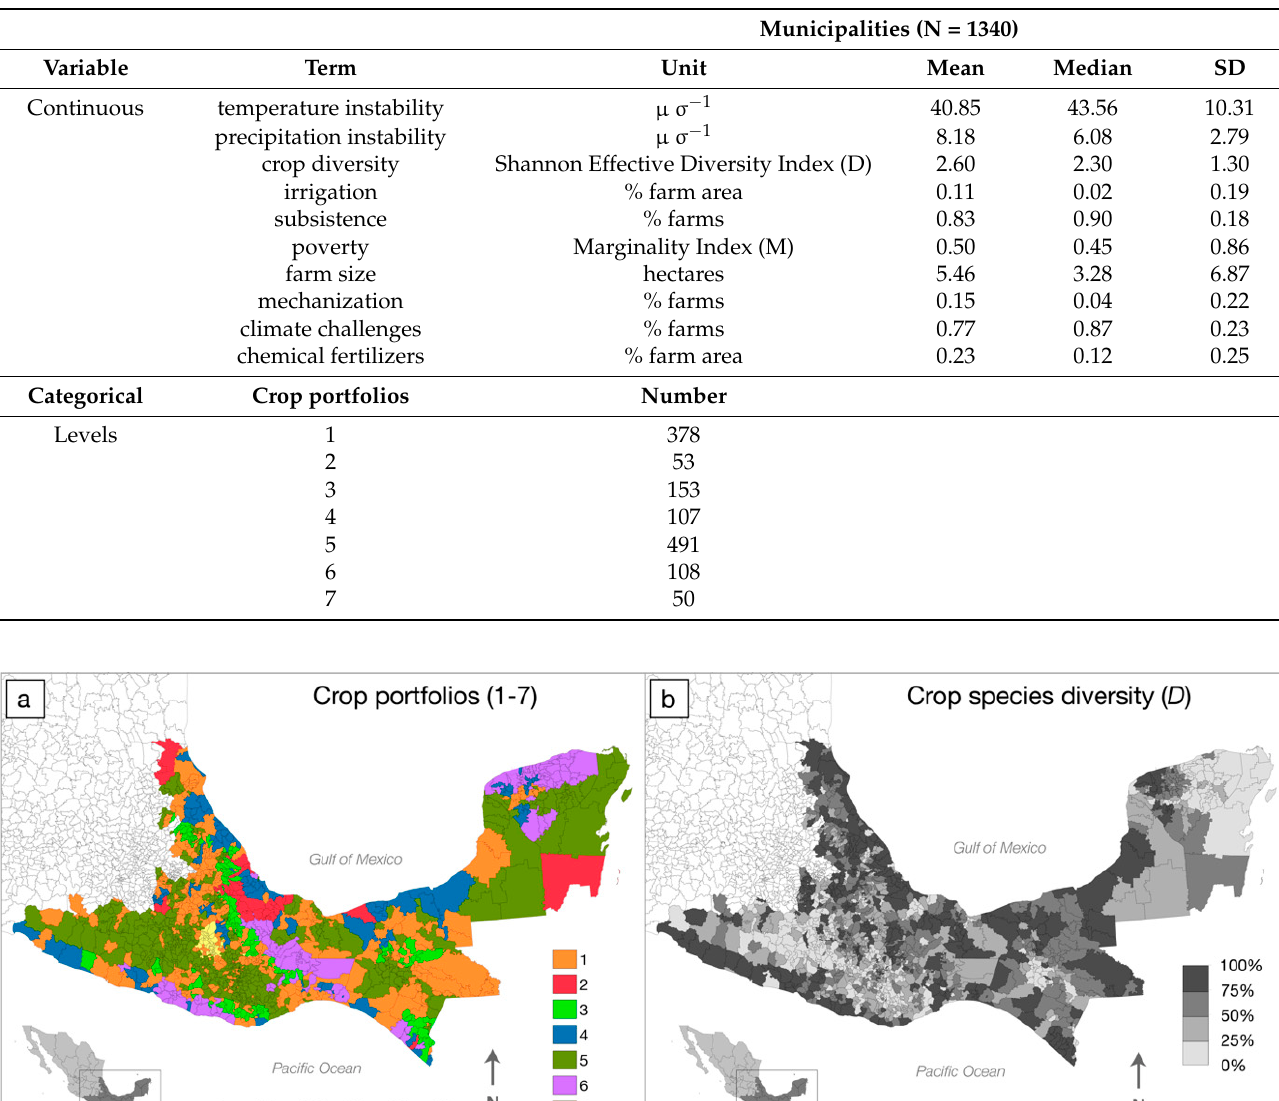
Table A1. Descriptive statistics for independent variables in the study area.